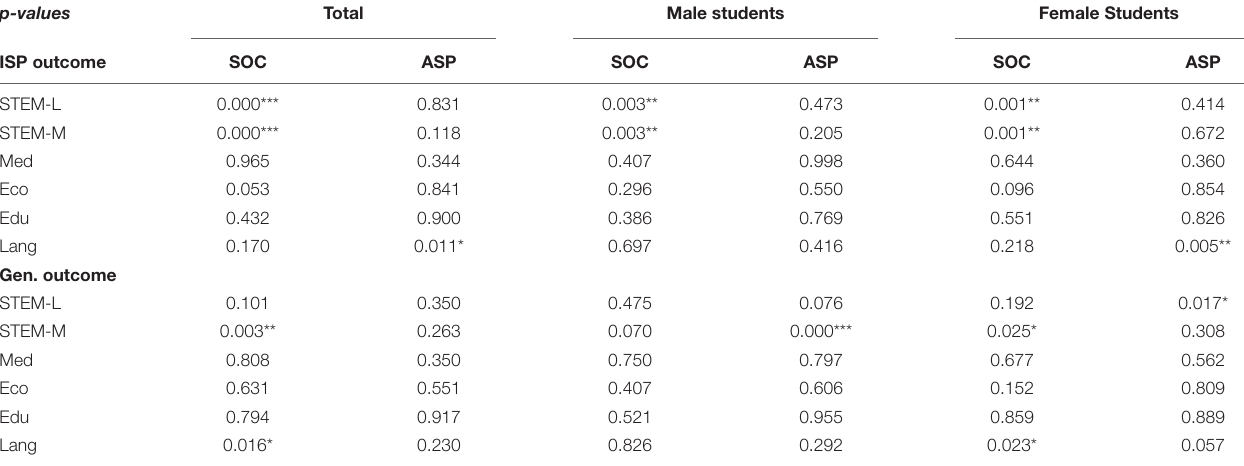
TABLE 2 | p -values for differences with respect to social congruence (SOC) and aspirational congruence (ASP) for all students (Total) and separate for male and female students for the different subject areas with respect to their initial study program (ISP) and general study outcomes. p-values Total Male students Female Students ISP outcome SOC ASP STEM-L